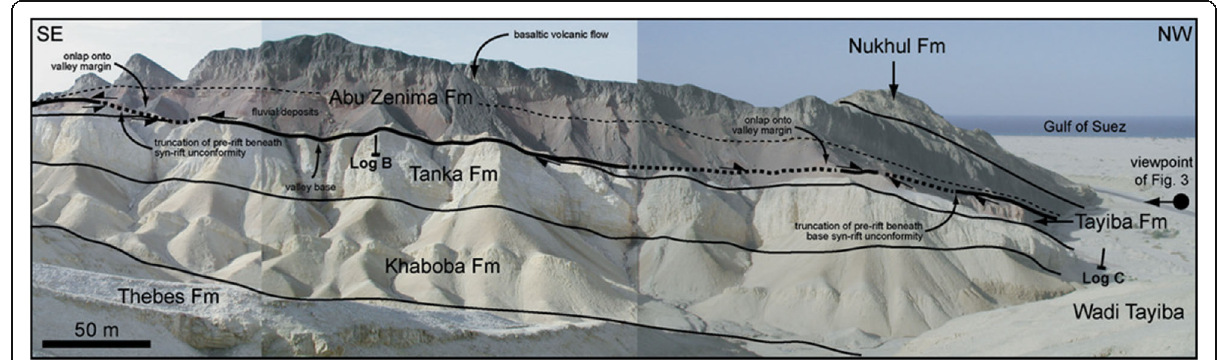
Fig. 2 Photograph map SE showing the stratigraphic section at the entrance to Wadi Tayiba, appearance Thebes, Khaboba, Tanka and Tayiba formations overlain by alluvial and volcanic deposits of the early syn-rift Abu Zenima Formation across a major sequence boundary (after Christopher